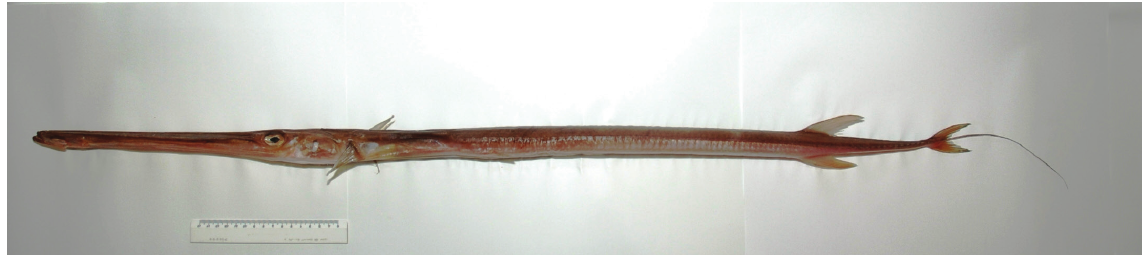
Fig. 3. Fistularia petimba Lacepède,